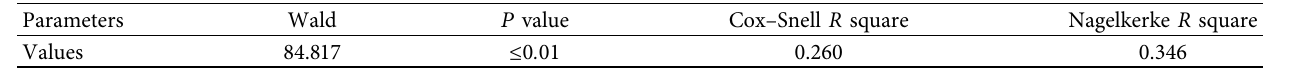
Figure 2: Distribution of time-space potential values of CB. Table 1: Summary table of model parameters.